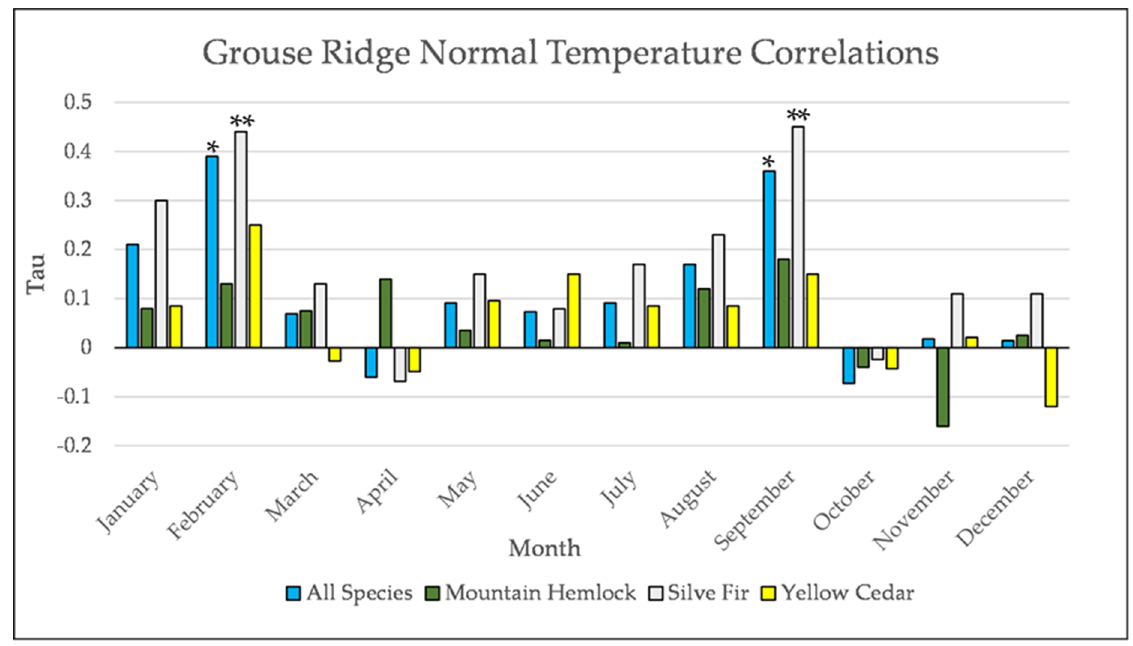
Figure A21 Normal Kendall’s correlation between mean monthly temperature and establishment at the Grouse Ridge site* = p -Value < 0.05, ** = p -Value < 0.01.